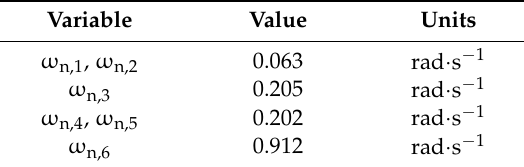
Table 4. Natural frequencies of the